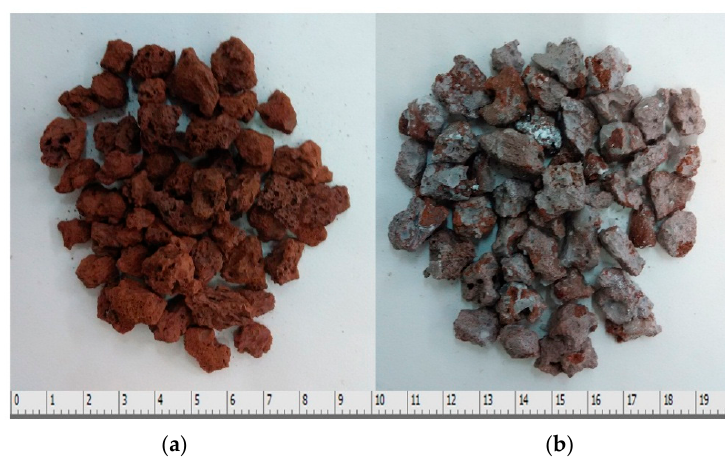
Figure 2. The used float stones and the immersed composite PCM: ( a ) float stones, and ( b ) immersed composite PCM.